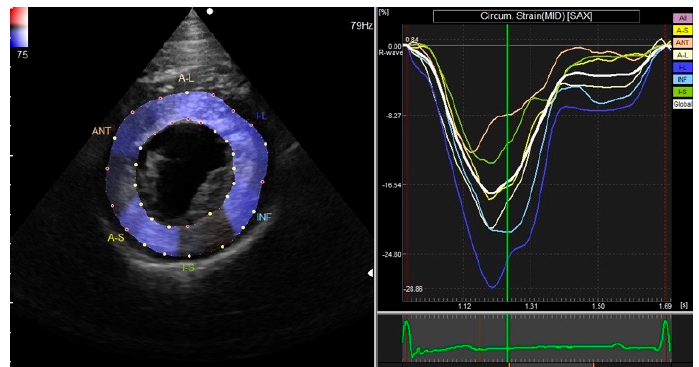
Figure 2. Global peak strain in the circumferential direction obtained via right parasternal short-axis view at the level of the papillary muscle.